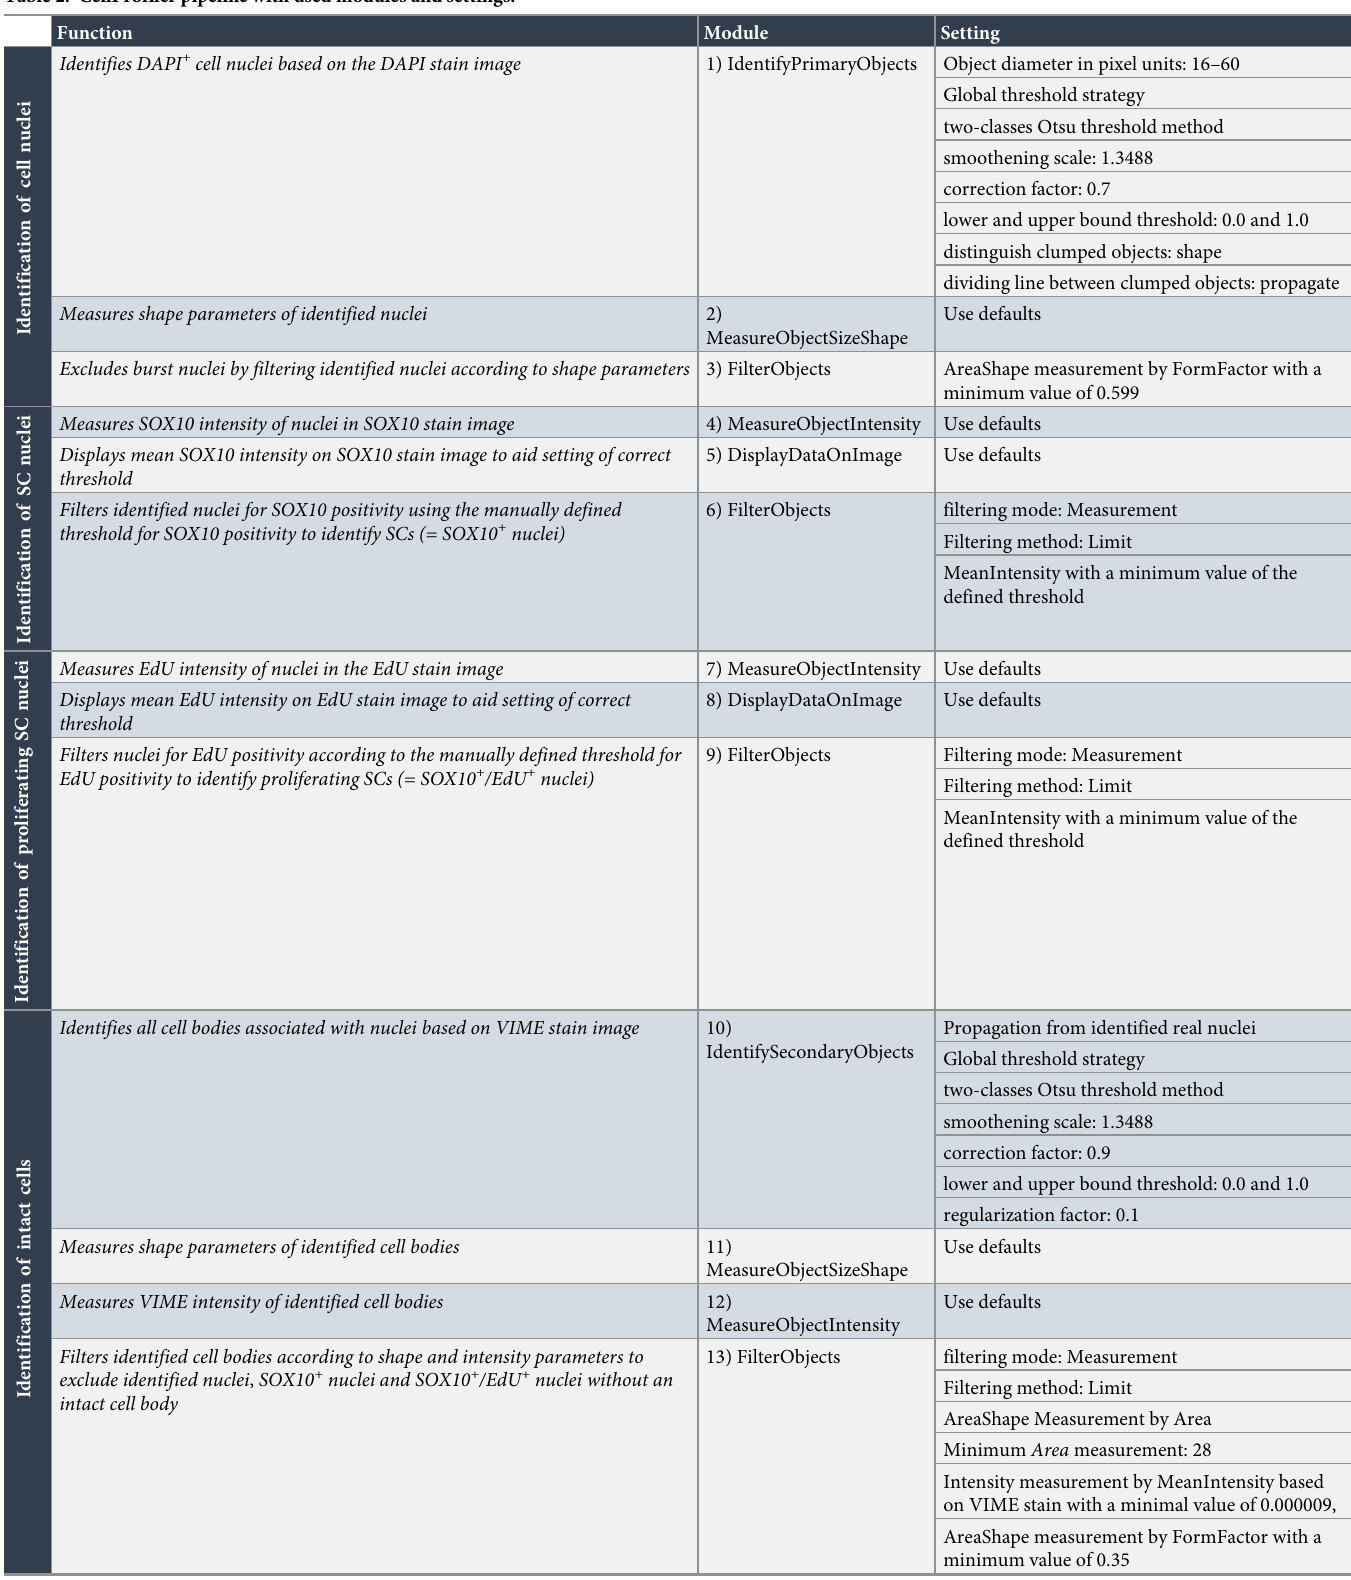
Table 2. CellProfiler pipeline with used modules and